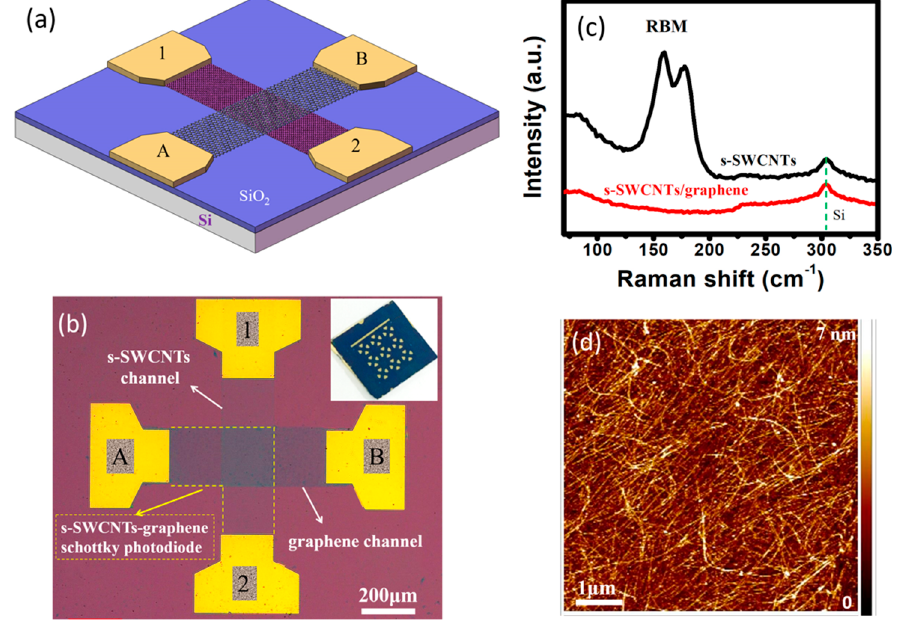
Figure 2. Schematic ( a ) and optical image ( b ) of the graphene/s-SWCNTs cross-shaped photodiode. ( c ) The radial breathing mode (RBM) range of Raman spectrum for the s-SWCNT film before and after overlapping graphene. ( d ) The AFM image of the graphene/s-SWCNT film overlap area.